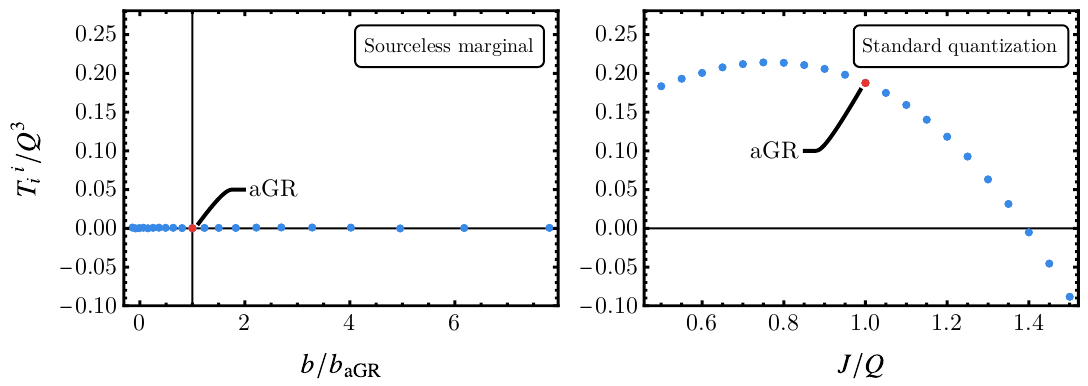
Figure 3 . Trace of the boundary stress tensor when varying the Dirichlet boundary condition ψ (0) . This can be interpreted as exploring boundaries with a = 0 , J = 0 and varying marginal coupling b (left) or as changing the source J = α in standard quantization (right). aGR denotes the analytically known Gubser-Rocha solution. (Left) We see that in this case, T ij remains traceless regardless of b which is consistent with a marginal deformation and the result (3.16). (Right) In standard quantization, the trace is generically not zero, but this can happen for specific boundary theories: